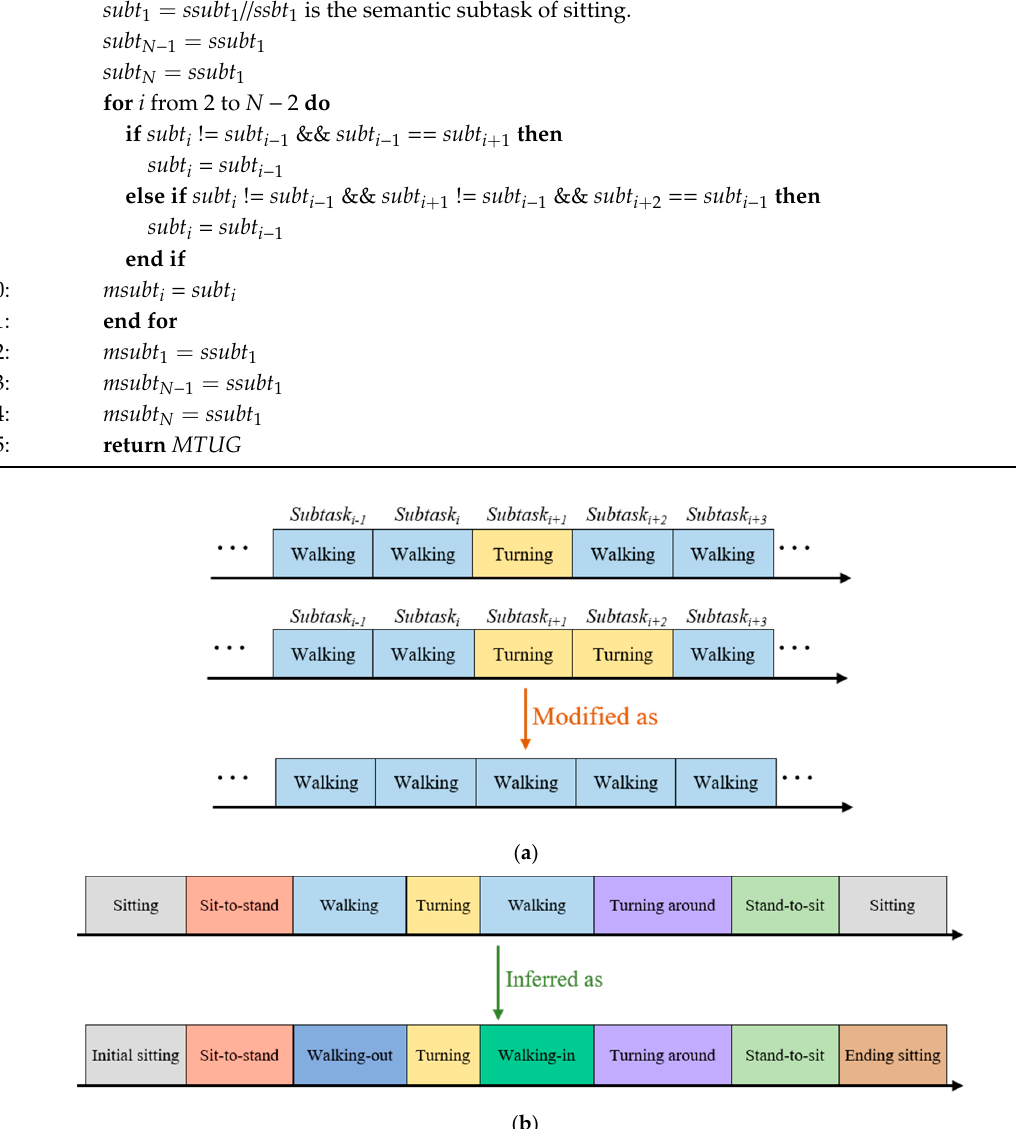
Algorithm 1: Fragmentation modification algorithm in the knowledge-based postprocessing stage